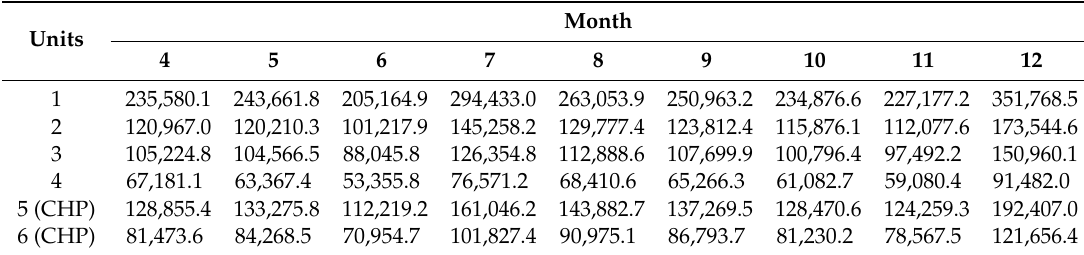
Table 11. The scheduled energy of thermal power units using the load rate deviation method.